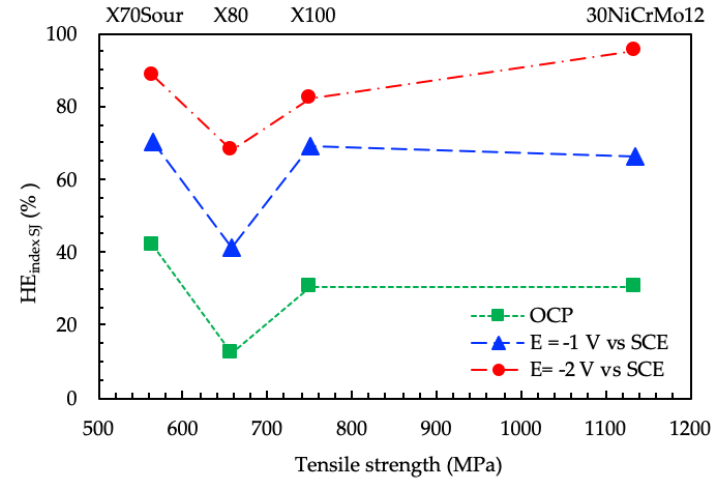
ff ect of mechanical properties on the HE Figure 16. Effect of mechanical properties on the HE indexJS. Figure 16. E